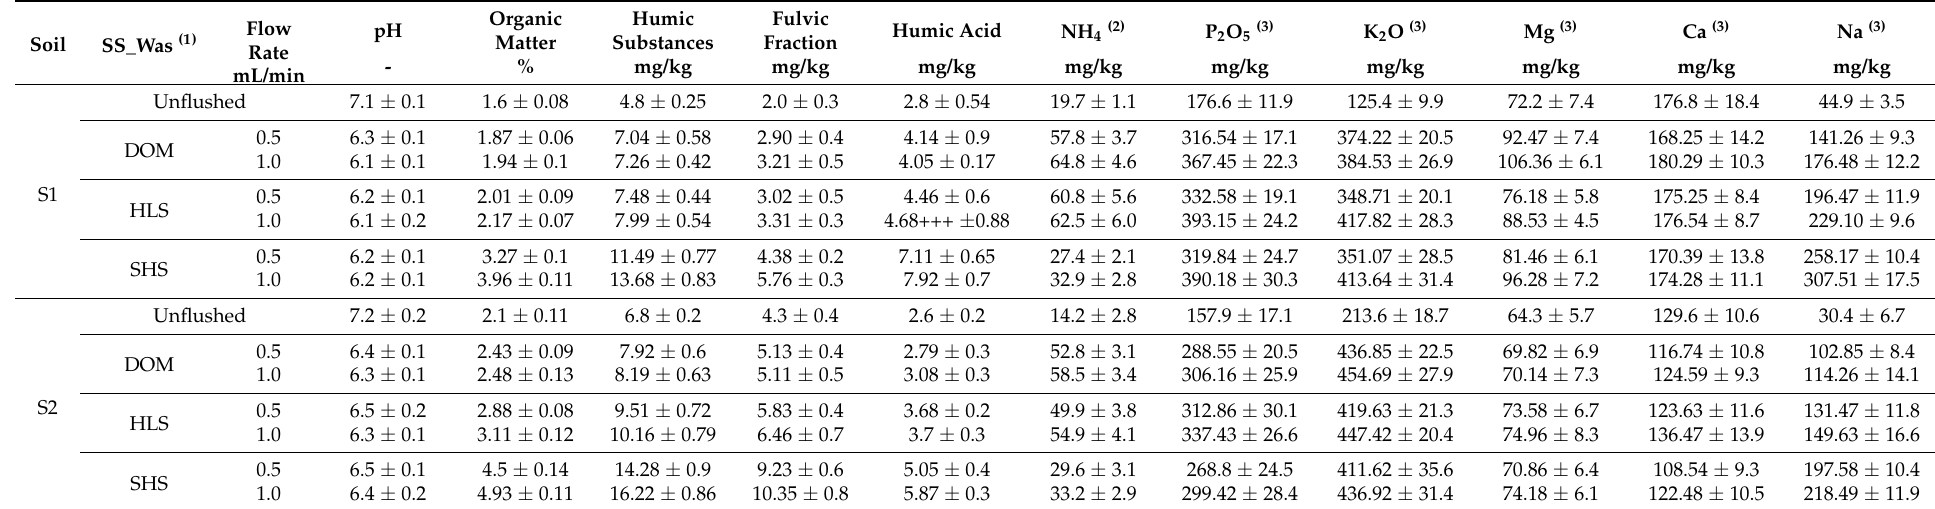
Table 2. Physicochemical characteristics of the soils ( n = 3, ± standard